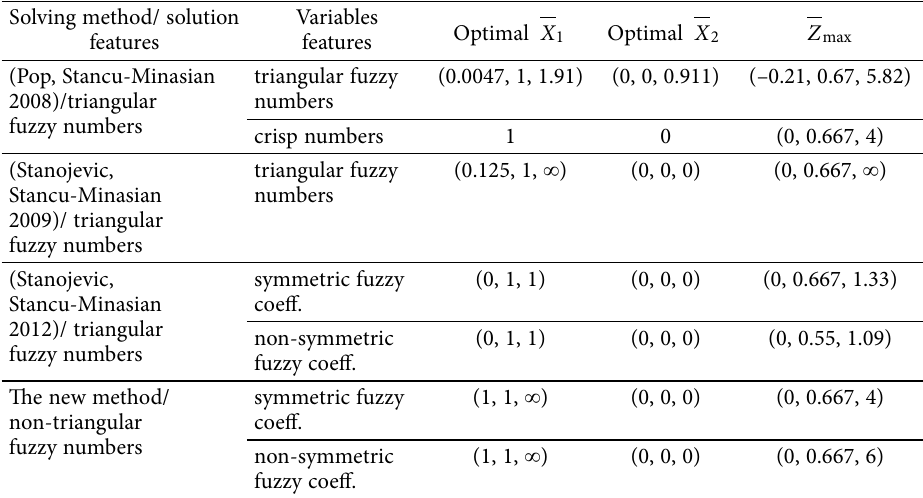
Table 1. The solutions to Problem (10) for comparison Solving method/ solution